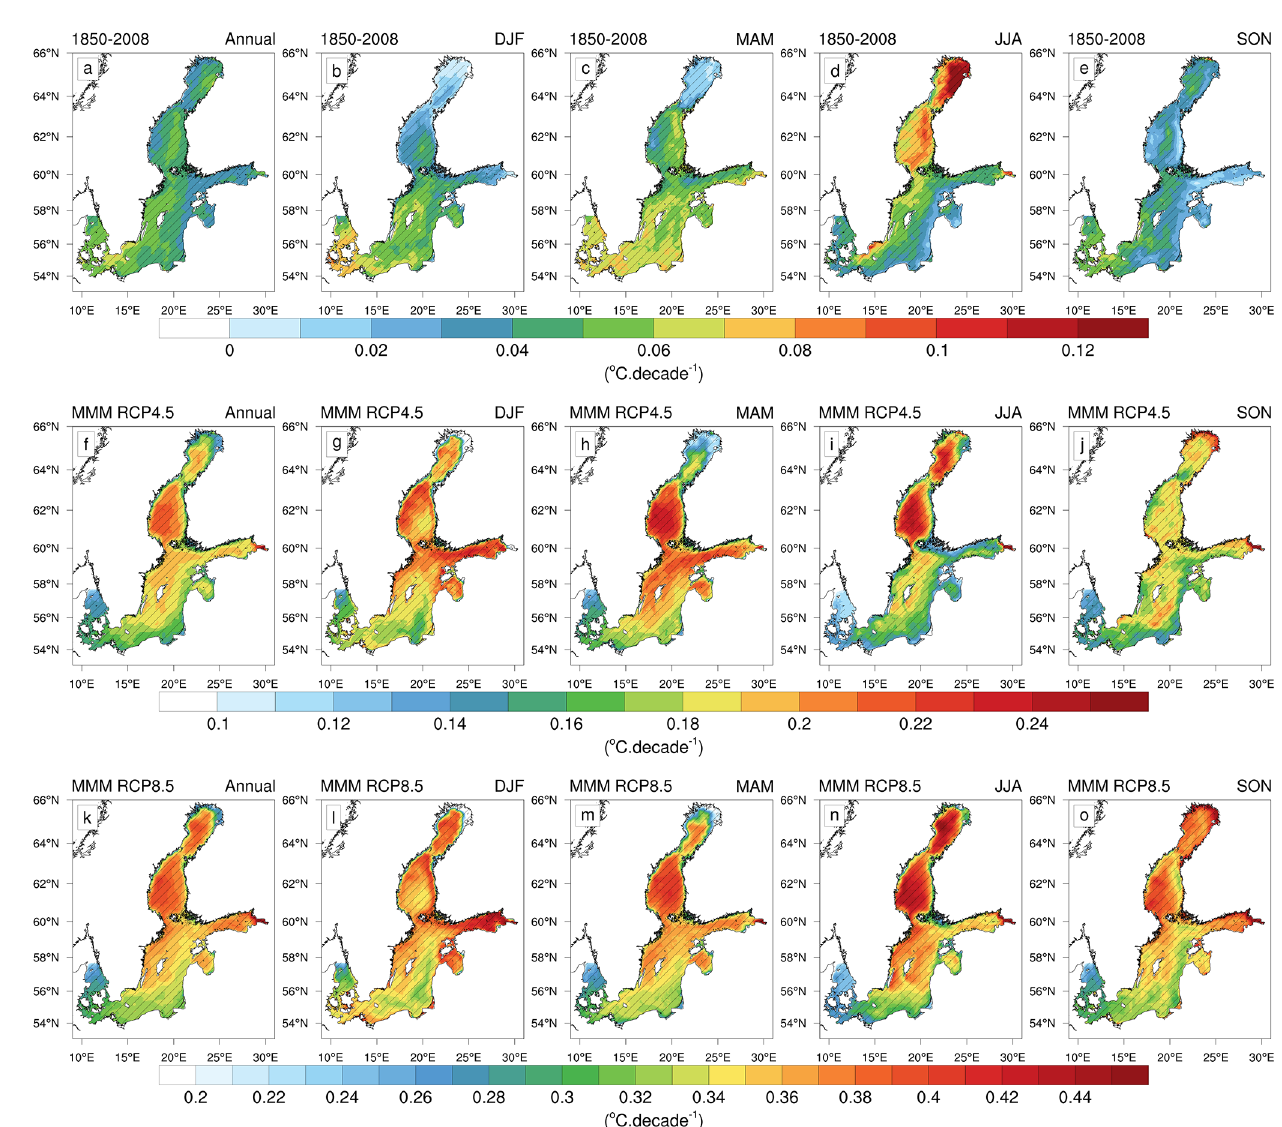
Figure 13. Multi-model mean (MMM) of annual (a, f, k) and seasonal (b–e, g–j, l–o) SST trends (in ◦ C per decade) computed for the period 1850–2008 (a–e) , 2006–2099 in the RCP4.5 (f–j) and RCP8.5 (k–o) scenarios. Hatched areas represent the regions where the trend is statistically significant ( p < 0 . 05, Mann–Kendall test). Data for historical reconstructions and projections are from Meier et al. (2019d) and Saraiva et al. (2019a), respectively (cf. Dutheil et al.,